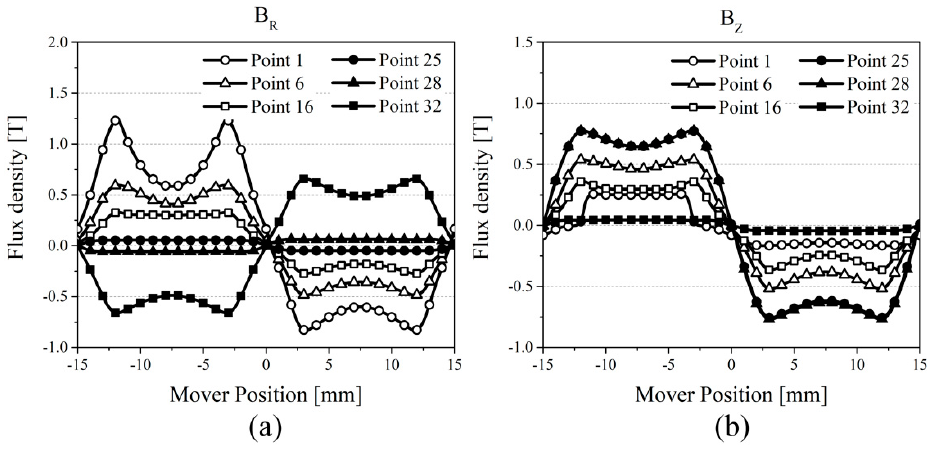
Figure 8. Flux density in each point of stator according to flux direction: ( a ) radial and ( b ) axial.